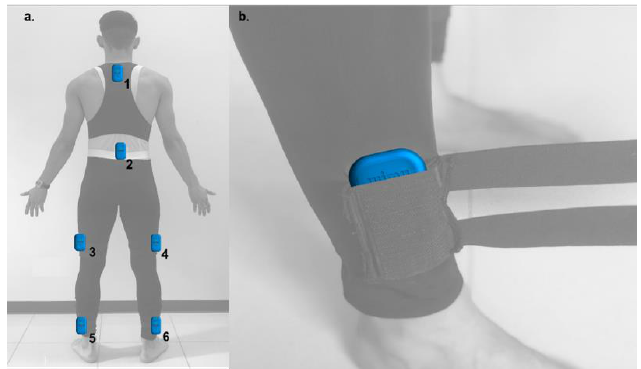
Figure 2. IMU device’s setting ( a ) 1: T 2 –T 4 , 2: L 1 –L 3 , 3: VL left and 4: VL right vastus lateralis, 5: MP left and 6: MP right malleolus peroneus; ( b ). body attachment anti-vibration straps system.